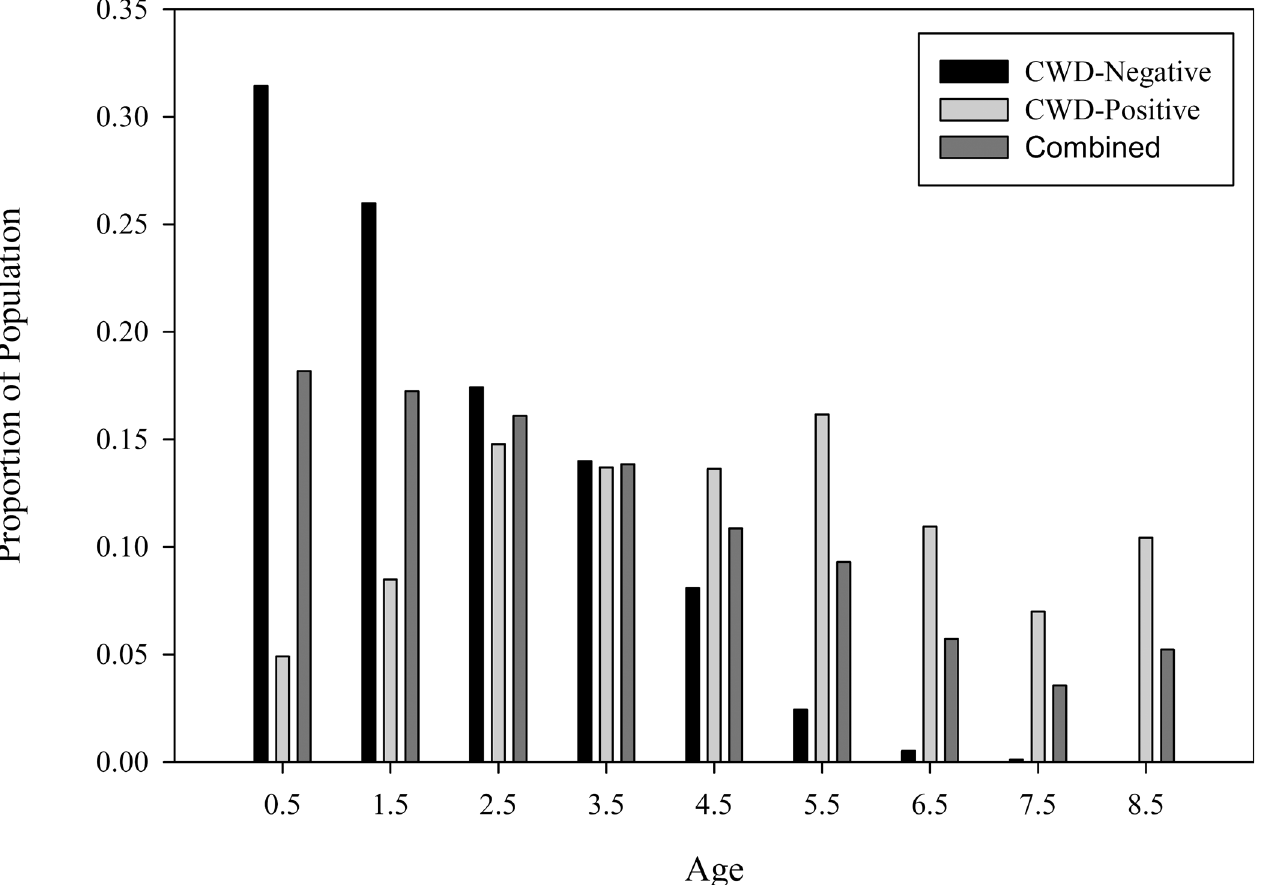
Fig 5. Population Age Structure. Proportional age structure of females separate by chronic wasting disease (CWD)-status and combined CWD- negative and CWD-positive deer of white-tailed deer captured, CWD-tested annually, marked with radio transmitter, and monitored by radio- telemetry SW of Glenrock, WY (2003 – 2010). Age structure was calculated from the dominant right eigenvector, w 1 , of the Leslie matrix population model of the transition matrix, A . The CWD-negative age structure was the result of assuming 0% CWD incidence modeled with a 9x9 ANeg transition matrix, the CWD-positive age structure was the result of assuming 100% CWD incidence with a 9x9 APos transition matrix, and the combined age structure was the result of modeling what is occurring in this population currently based on the 18x18 combined transition matrix, A ; this result represents the actual population age